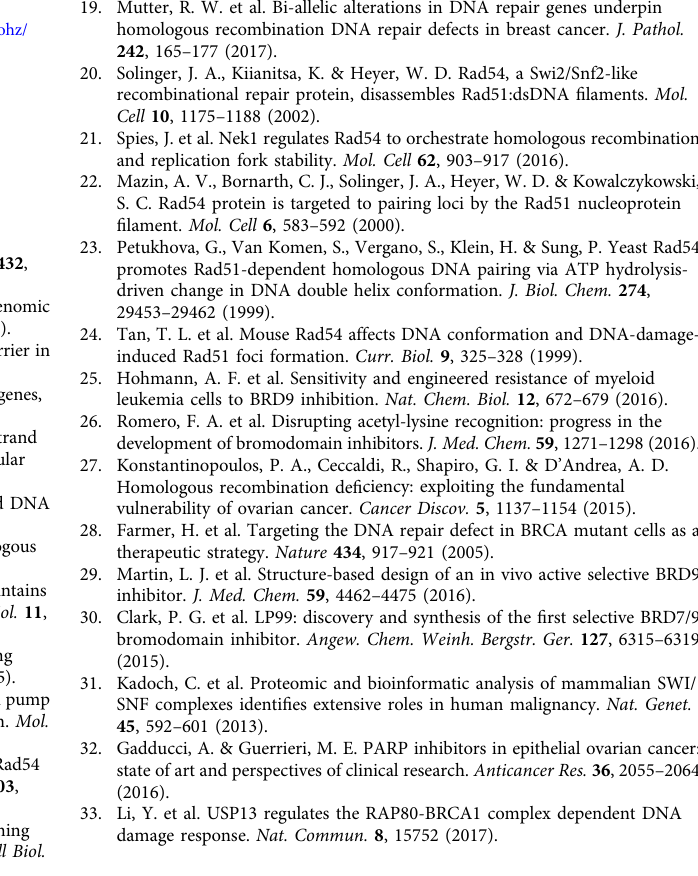
Fig. 5 BRD9 is overexpressed in ovarian cancer and regulates response to DNA-damaging agents. a – c BRD9 is overexpressed in ovarian cancer patient samples and cell lines, and is associated with decreased patient survival. a Analysis of BRD9 expression in ovarian cancer patient samples from the TCGA database. Red indicates BRD9 ampli fi cation. b Kaplan – Meier curve showing the survival of ovarian cancer patients with low ( n = 720) and high ( n = 715) expression of BRD9. Statistical analysis with the two-sided log-rank (Mantel – Cox) test revealed statistically signi fi cant differences as shown on the graph. c Immunoblot of indicated proteins in the indicated ovarian cancer cell lines. d – g Depletion/inhibition of BRD9 sensitizes OVCAR8 cells to PARPi and cisplatin. d – f OVCAR8 cells infected with indicated shRNAs and subjected to WB assay ( d ) to assess knockdown ef fi ciency, and colony-formation assay to assess the sensitivity to olaparib ( e ) and cisplatin ( f ). g OVCAR8 cells were exposed to olaparib and/or BRD9i and subjected to colony-formation assay. Representative data (mean ± SEM) are shown from n = 3 biologically independent samples. ** p < 0.01,*** p < 0.001 by two-sided unpaired t test. h – j Overexpression of BRD9 confers resistance to PARPi/cisplatin. OVCAR7 cells infected with the indicated lentivirus and subjected to colony-formation assay to assess the sensitivity to olaparib ( i ) and cisplatin ( j ). Protein expression was assessed by Western blot ( h ). Representative data (mean ± SEM) are shown from n = 3 biologically independent samples. ** p < 0.01,*** p < 0.001 by two-sided unpaired t test. k , l Depletion/inhibition of BRD9 sensitizes OVCAR8 cells to PARPi in vivo. k OVCAR8 cells expressing the indicated shRNAs were subcutaneously injected into the fl ank of NOD-SCID mice. Mice were treated with or without olaparib (50 mg/kg i.p. 3 days × 8 times). Tumor volume and weight were assessed ( l ). OVCAR8 cells were subcutaneously injected into the fl ank of NOD-SCID mice. Mice were treated with vehicle (normal saline, NS), olaparib (PARPi, 50 mg/kg), BRD9i (40 mg/kg i.p. 3 days